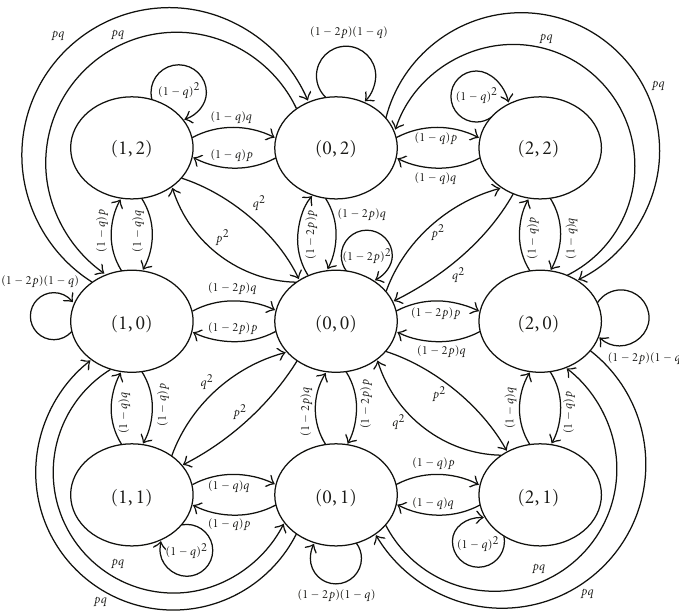
Figure 4: Example of state-transition diagram for the SIMM model—the components i and j (of the two-dimension vector states ( i , j )) describe the shifts made by the mobile node (MN) in directions x and y , respectively.